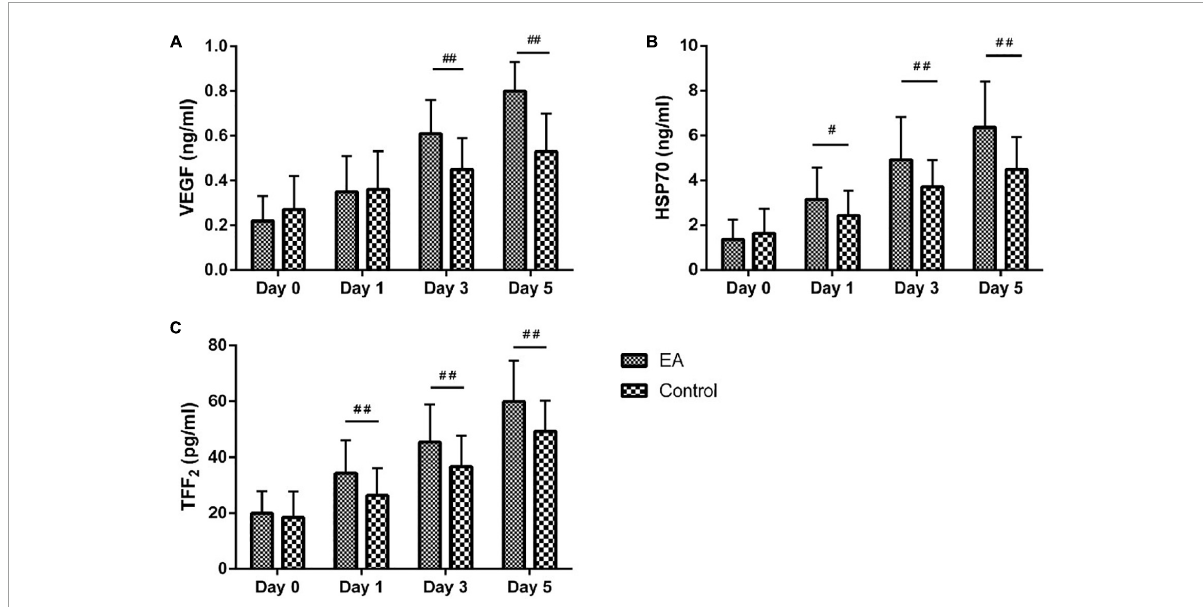
FIGURE3 Comparison of serum vascular endothelial growth factor (VEGF), heat shock protein 70 (HSP70), and trefoil factor family 2 (TFF2) levels between the two groups. (A) Comparison of serum VEGF level between the EA and control groups. (B) Comparison of serum HSP70 level between the EA and control groups. (C) Comparison of serum TFF2 level between the EA and control groups. Day 0 = after admission, before operation; day 1 = 1 day after operation; day 3 = 3 days after operation; day 5 = 5 days after operation. # P < 0.05, ## P < 0.01.